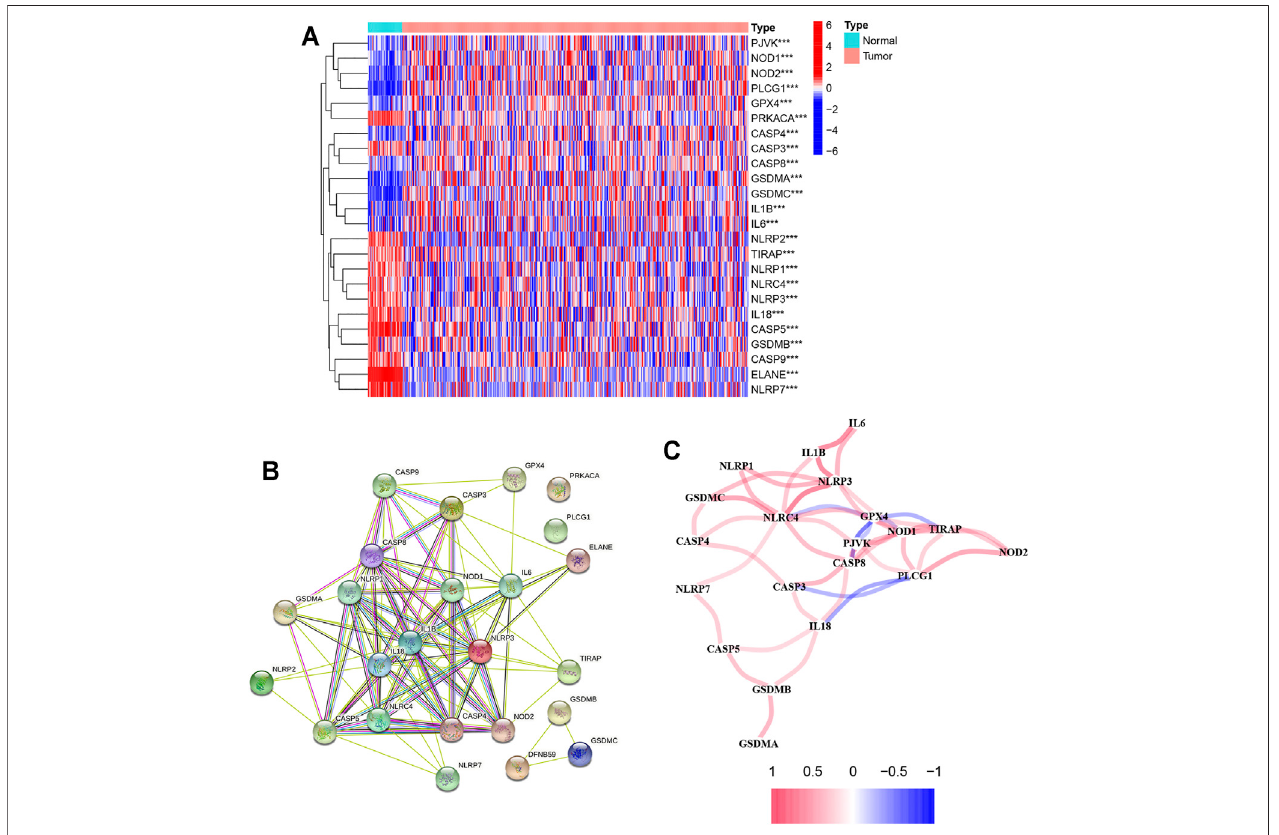
FIGURE 2 | Results of differential gene analysis. (A) Heatmap of differentially expressed pyroptosis-related genes. The vertical axis refers to genes, the horizontal axis refers to differences in the gene expression between tissues, the orange means high expression, and the blue means low expression. P-values are shown as: ** p < 0.01;*** p < 0.001; (B) PPInetworkshowingtheinteractionsofdifferentiallyexpressedpyroptosis-relatedgenes; (C) correlationofthedifferentiallyexpressedpyroptosis- related genes (red line: positive correlation; blue line: negative correlation. The depth of the colors re fl ects the strength of the